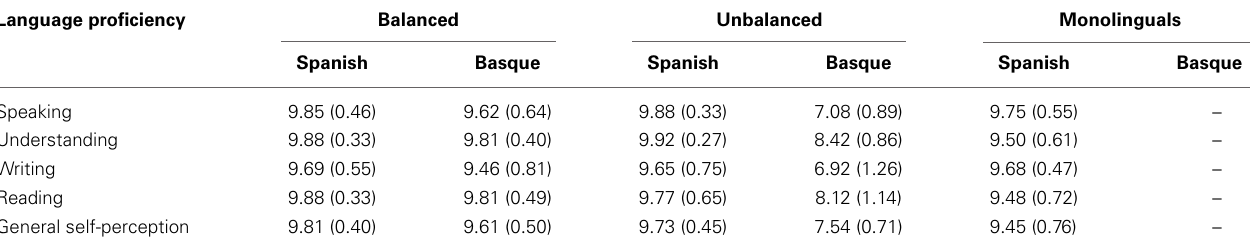
Standard deviations are provided within parentheses. Table 2 | Mean values for each sub-lexical, lexical, and semantic factor of the L1 (Spanish) and L2 (Basque) word used split by condition.